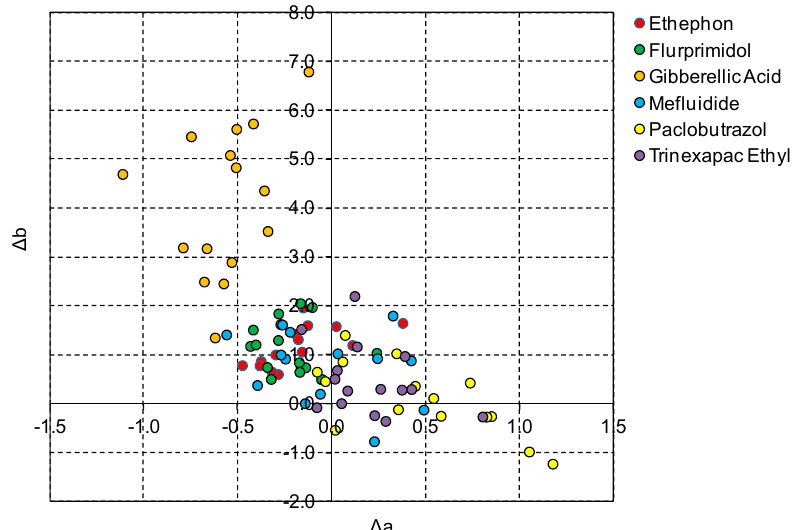
The ∆ a and ∆ b color parameters affected by PGR application are presented in Figure 2. Data points presenting results obtained for Ethephon, Flurprimidol, Mefluidide, and Trinexapac Ethyl are in the center of the coordinate system. This means that these PGRs did not change blue-yellow and green-red hues in comparison with untreated control.